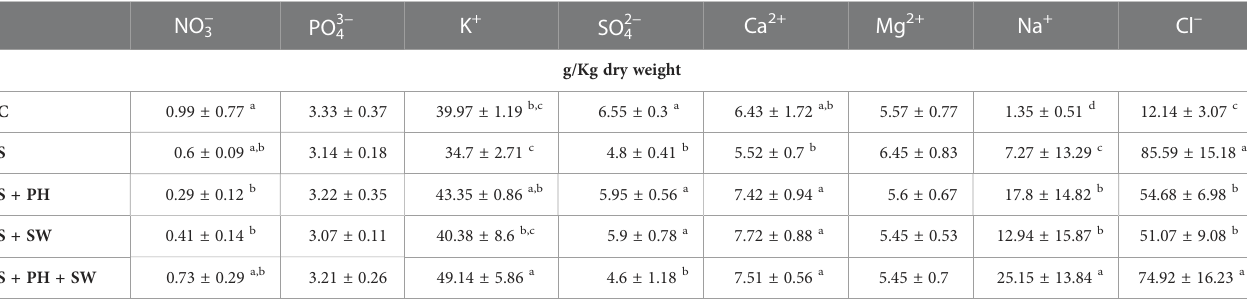
TABLE 1 Total minerals concentration of tomato leaves grown under salinity stress (S) and treated with biostimulants i.e., protein hydrolysate (PH), seaweed extracts (SW), and their combination PH + SW, compared to the control non-stressed plants (C).